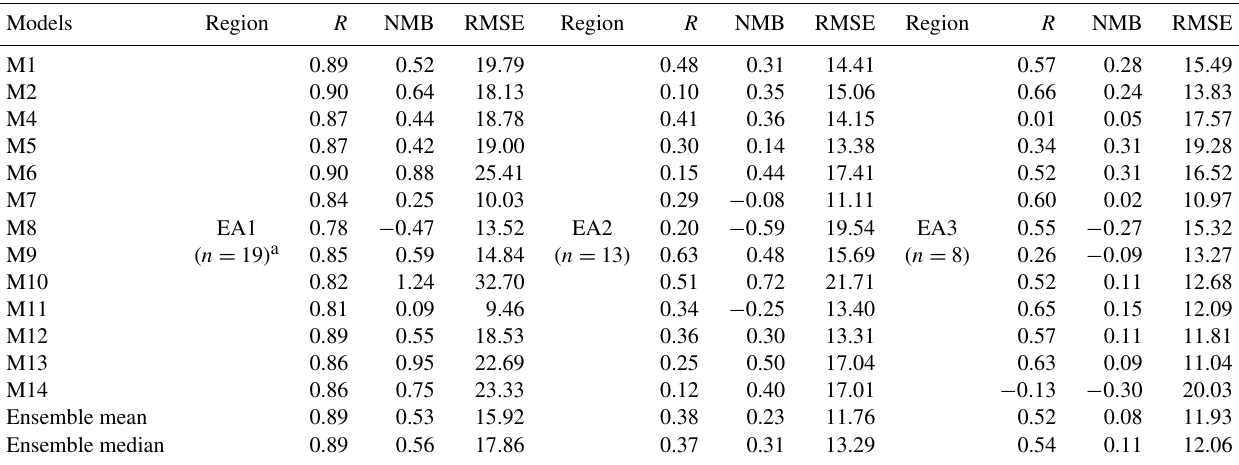
Table 2. Statistical analysis for surface O 3 in three subregions over East Asia. R denotes the correlation coefficient, NMB is the normalized mean bias and RMSE is the root-mean-square error (units are ppbv).